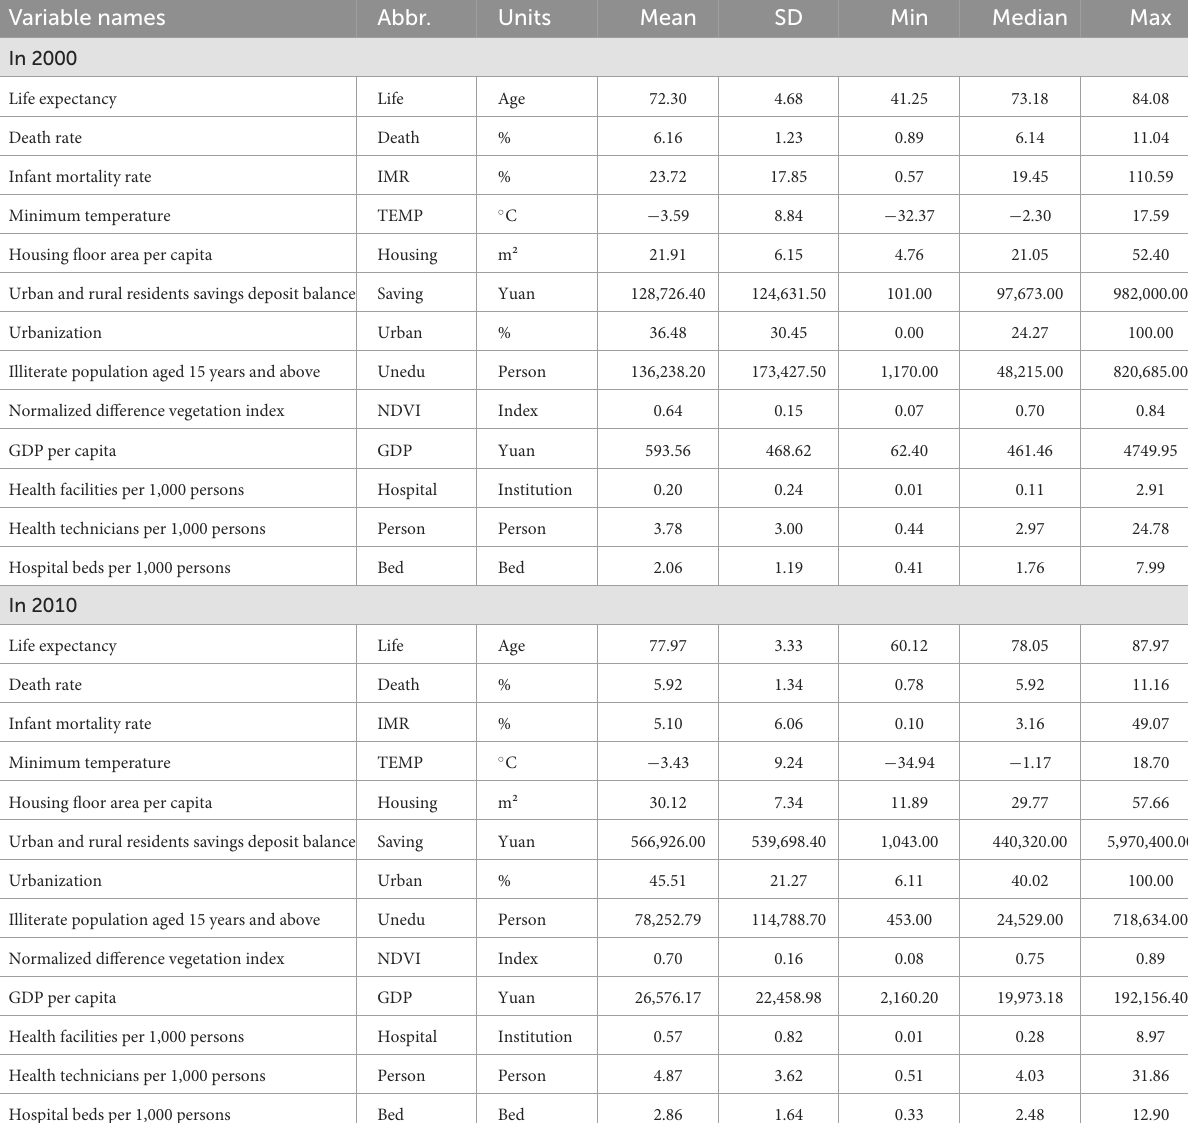
TABLE 2 Variable definitions and summary